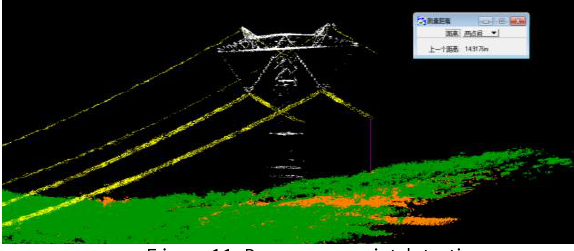
Figure 11. Dangerous point